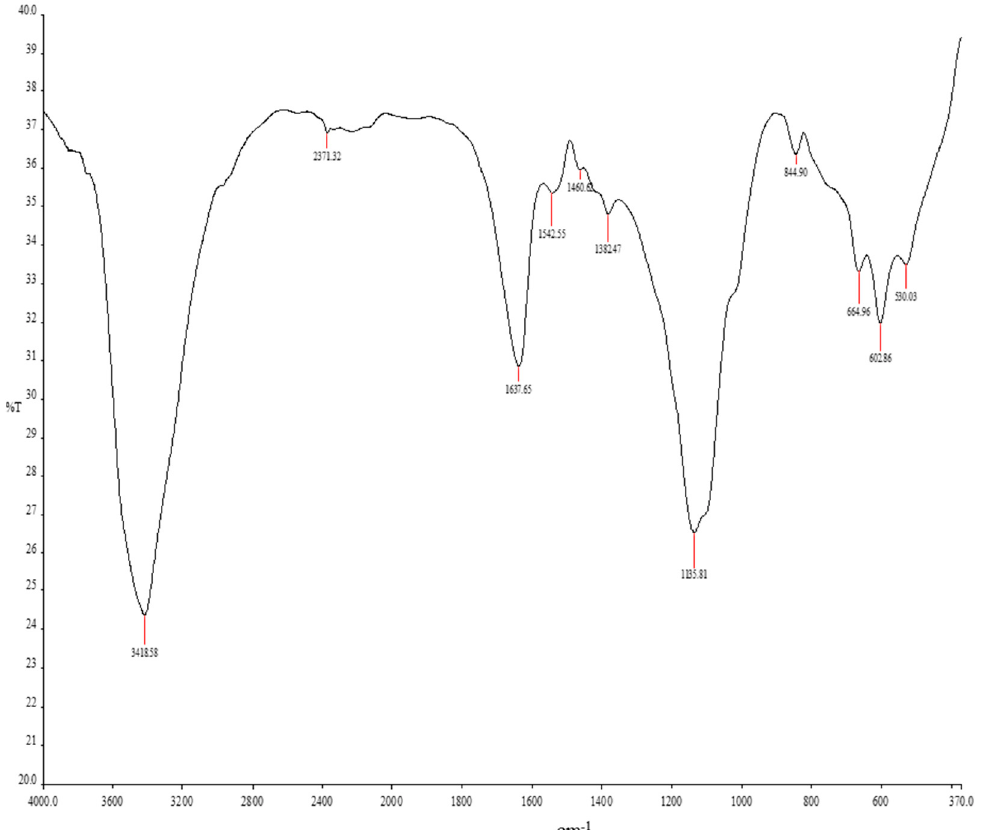
Figure 5. FTIR Spectroscopy of Purified Bioflocculant Produced by the Tested Strain ( Bacillus sp.).